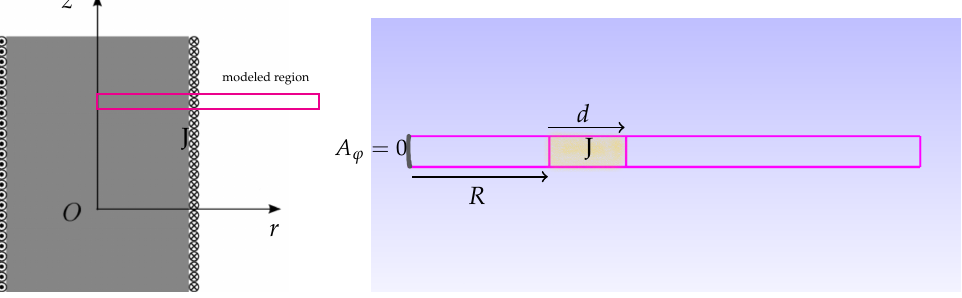
Figure 1. Infinite solenoid